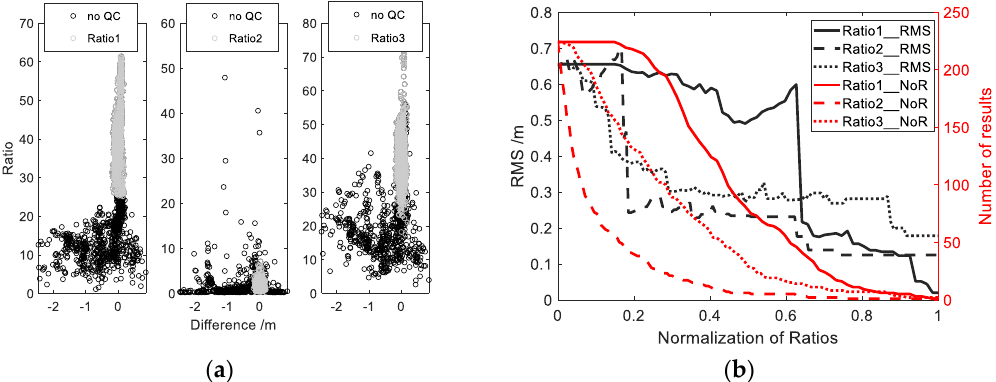
Figure 6 . ( a ) Errors at reservoir dam monitoring station and the relationship among three ratios. The X axis represents the difference between the measurements of the water level station and the results obtained by GNSS-IR technique; ( b ) Comparison of RMS and number of results for three quality control methods, NoR is a shorthand for number of results.